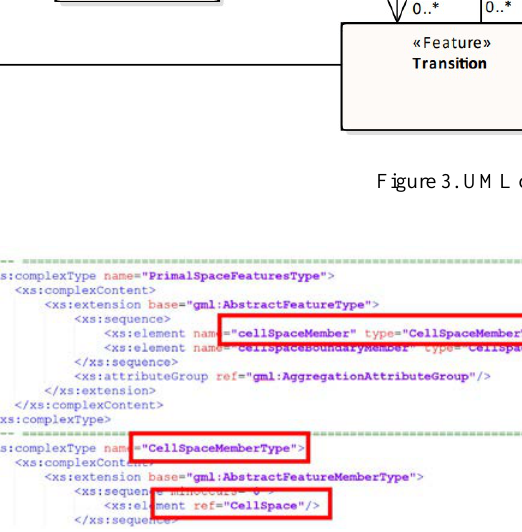
Figure 4. part of the XML schema of IndoorGML